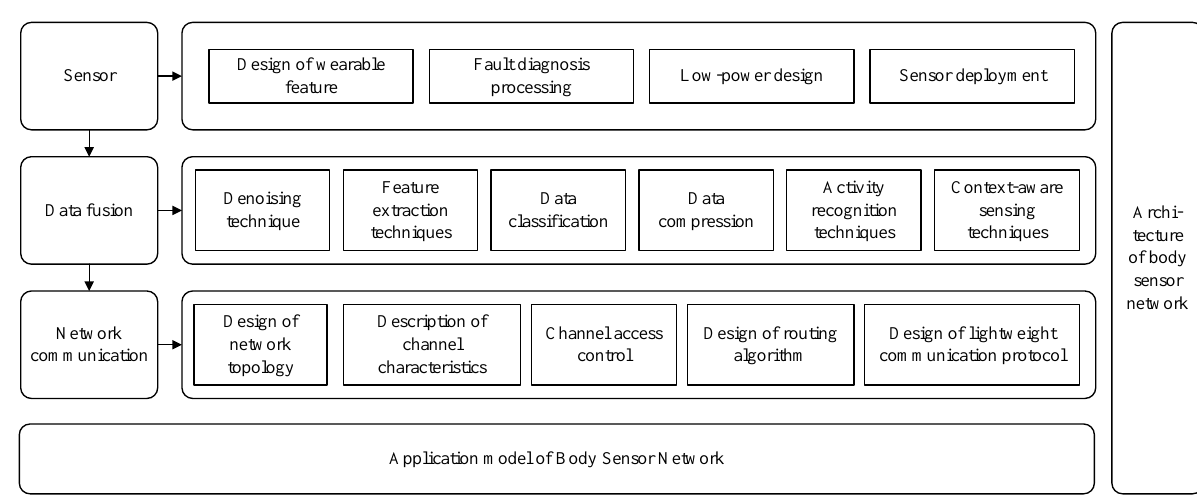
Figure 2. Main research areas in